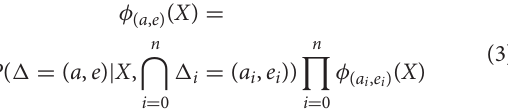
changes in the environment produced by an action